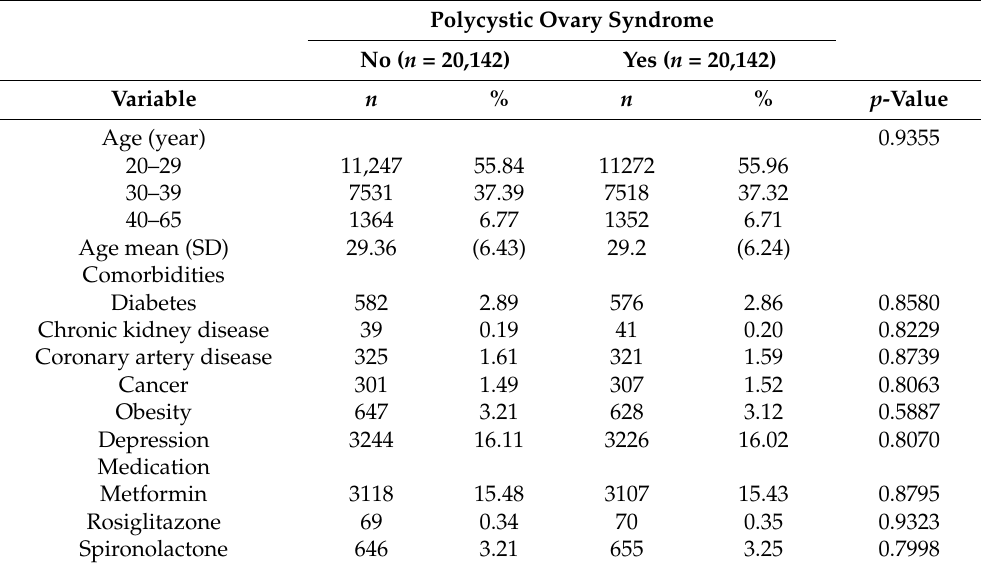
Table 1. The characteristics of patients with or without polycystic ovary